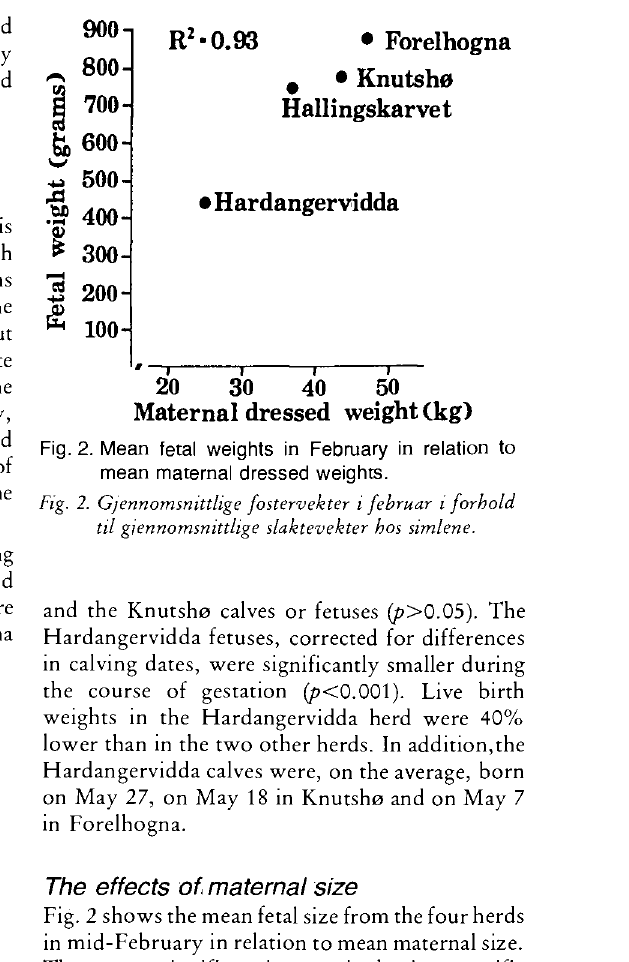
Fig. 1 . Time-specific exponential growth curves from three of the study herds. The curves were fitted on the mean weights (given with SD, shown as vertical bars).